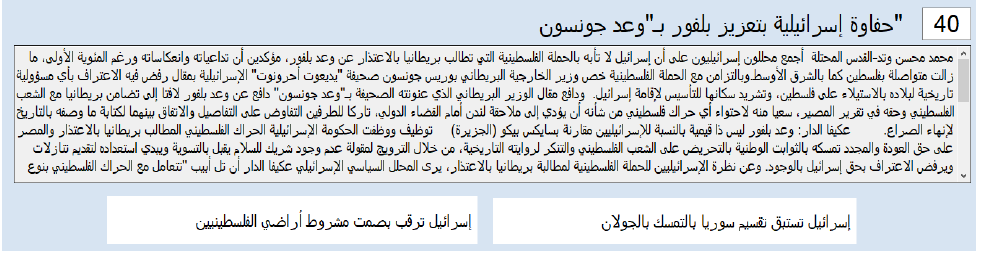
Figure A3. Sample number 1.